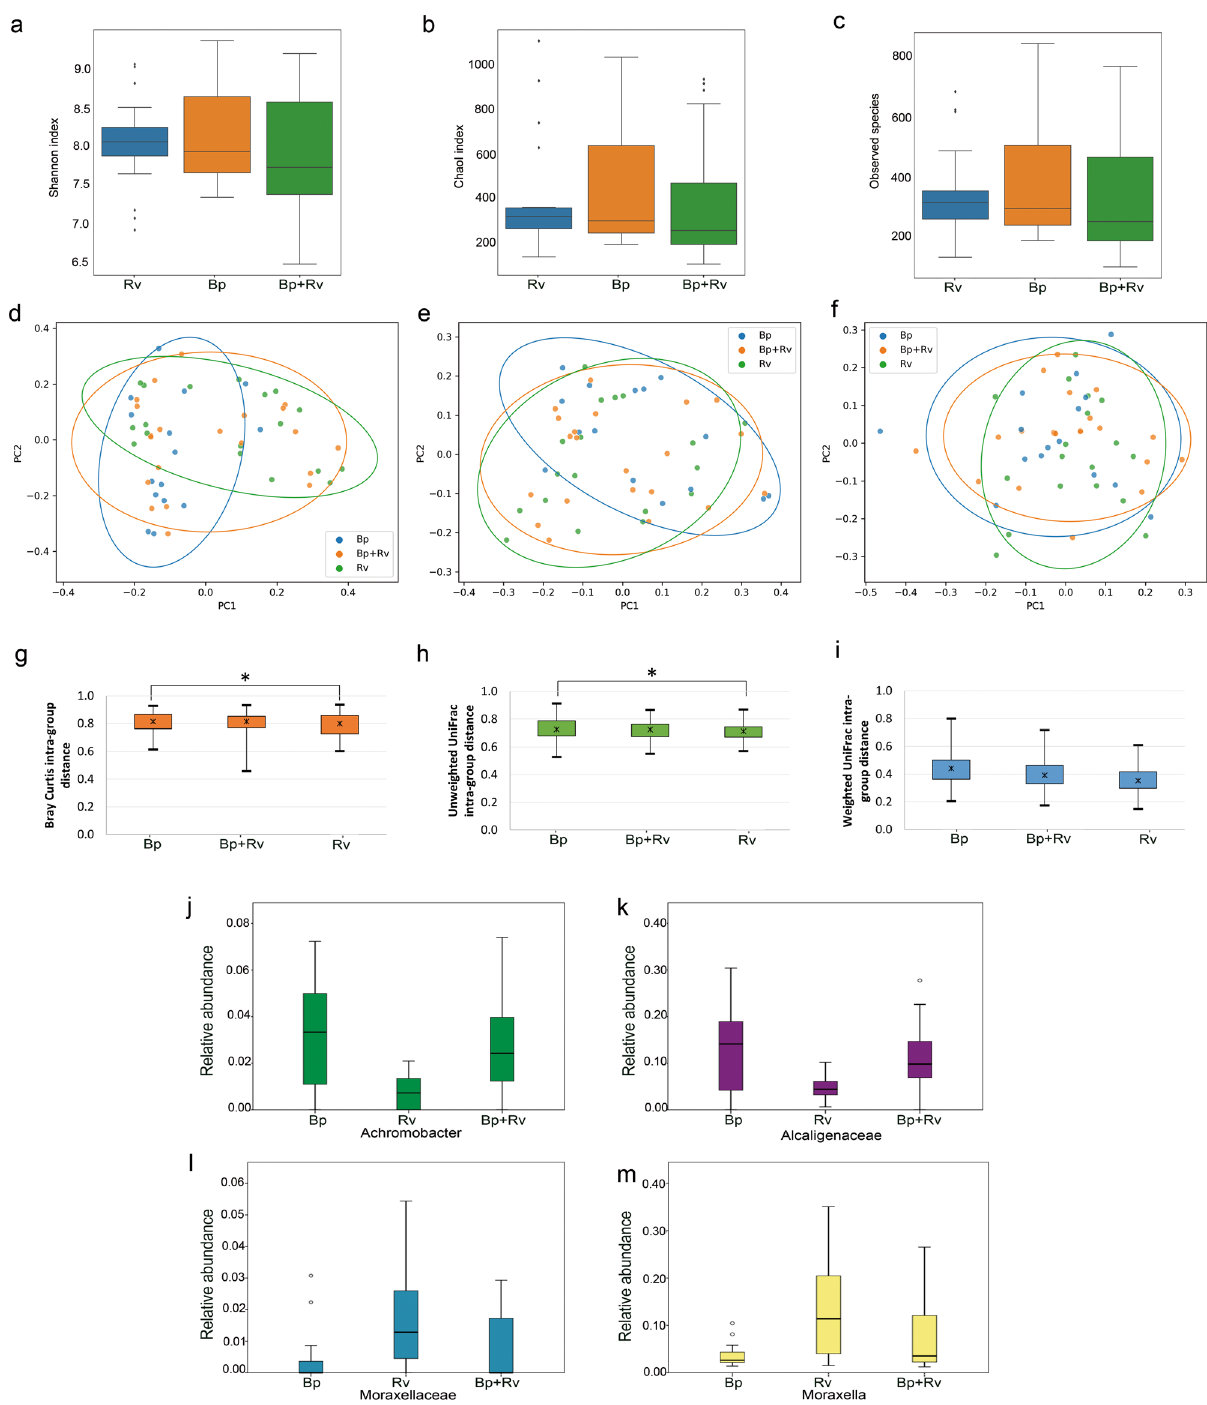
Figure 1. Microbiota diversity analysis. Alpha diversity analysis ( a – c ). Box plots show Shannon, Chao1, and Observed species indexes for each patients’ group. Microbiota beta diversity analysis ( d – f ). Principal coordinates analysis (PCoA) plot of bacterial beta-diversity based on Bray Curtis dissimilarity ( d ) and unweighted ( e ) and weighted ( f ) UniFrac phylogenetic distance. The plots show the first two principal coordinates (axes) of PCoA. Beta diversity distance box plots ( g – i ). Data are expressed as minimum, maximum and median values, and 25th and 75th percentiles values. The statistical significant differences are determined by permanova-pairwise tests and indicated by the star. Box plots of OTUs statistically significant by Kruskal–Wallis test ( j – m ). In y-axis are reported OTU’s relative abundances; in x-axis are reported median, minimum and maximum values, and the 25th and 75th percentile